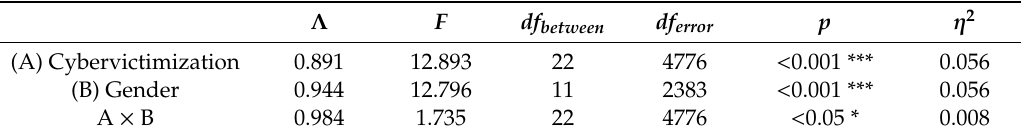
Table 2. Factorial MANOVA (4 ×